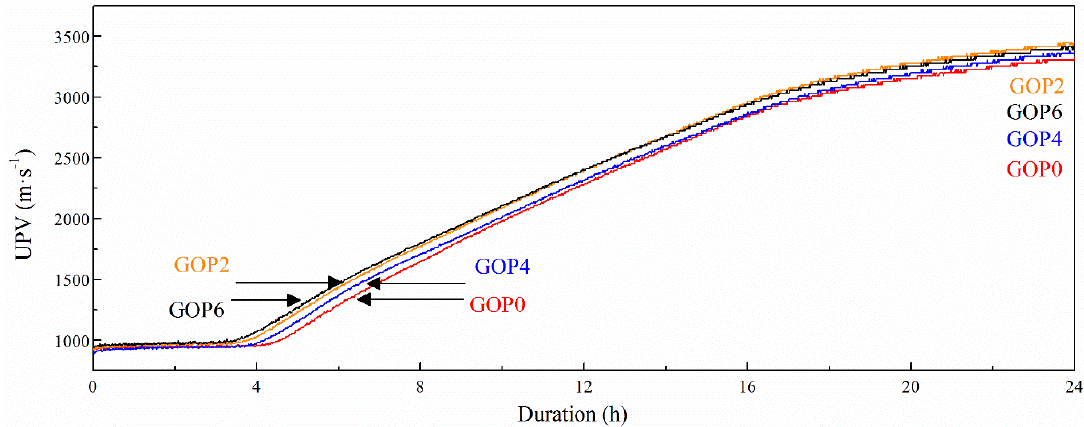
Figure 5. Ultrasonic Pulse Velocity (UPV) as a function of time for the plasticized cement pastes.